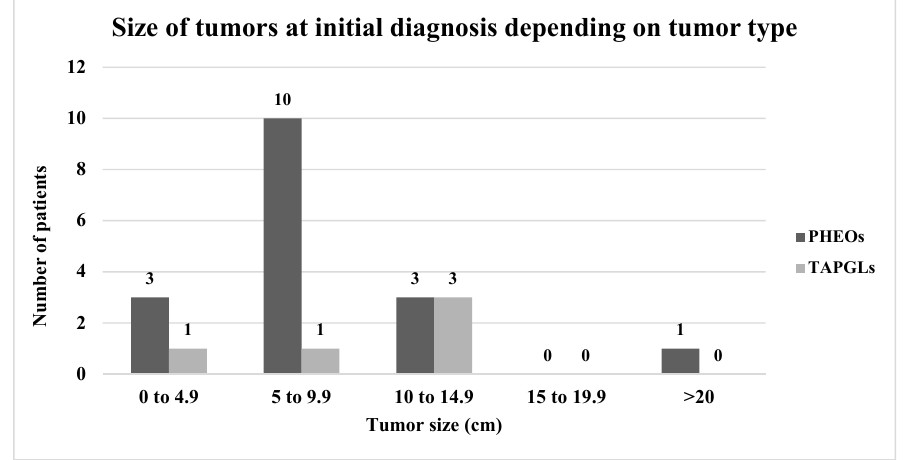
Figure 4. Size of tumors at initial diagnosis depending on tumor type. Notes: PPGLs: pheochromo- cytomas and paragangliomas, PHEOs: pheochromocytomas, TAPGLs: thoracoabdominal paragan- gliomas. * Tumor size missing for 3 PHEOs. ** Tumor size missing for 1 TAPGL .